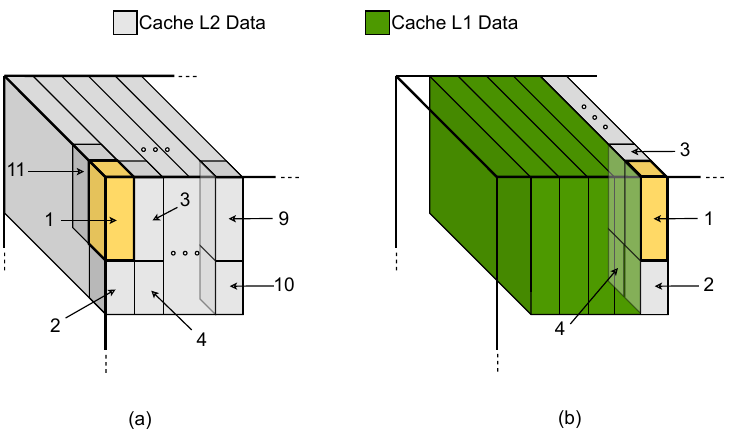
Figure 4. Scheduling operations and Cache L2-L1 behavior for filter size f = 5 × 5 with horizontal stride S w = 1. The numbers indicate the position of the yellow box at consecutive clock